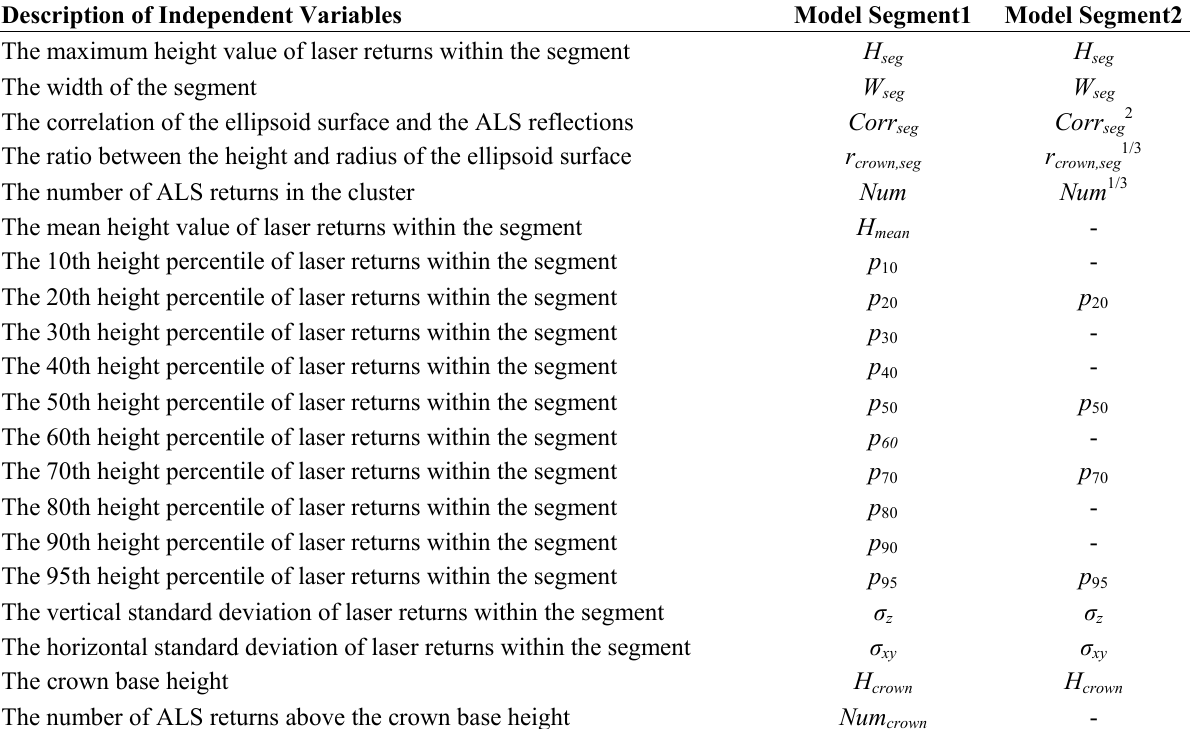
Table 3. Independent variables derived from the segments.